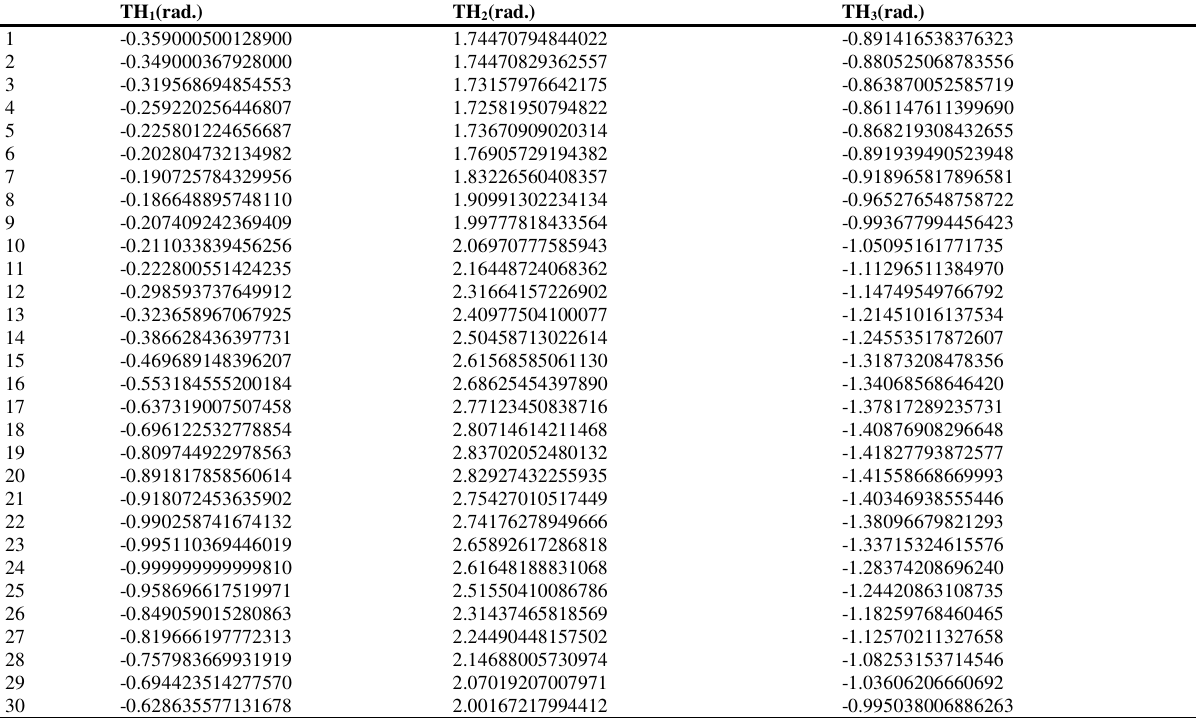
Best three joints angles results of the circular trajectory for three link redundant robot.